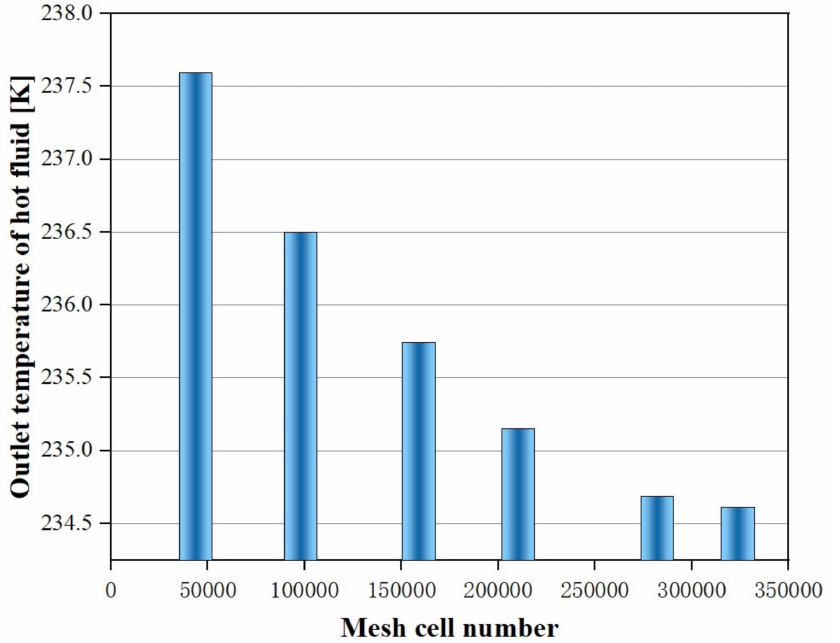
Figure 7. Results of the grid test for the exit temperature of the hot fluid versus the grid cell